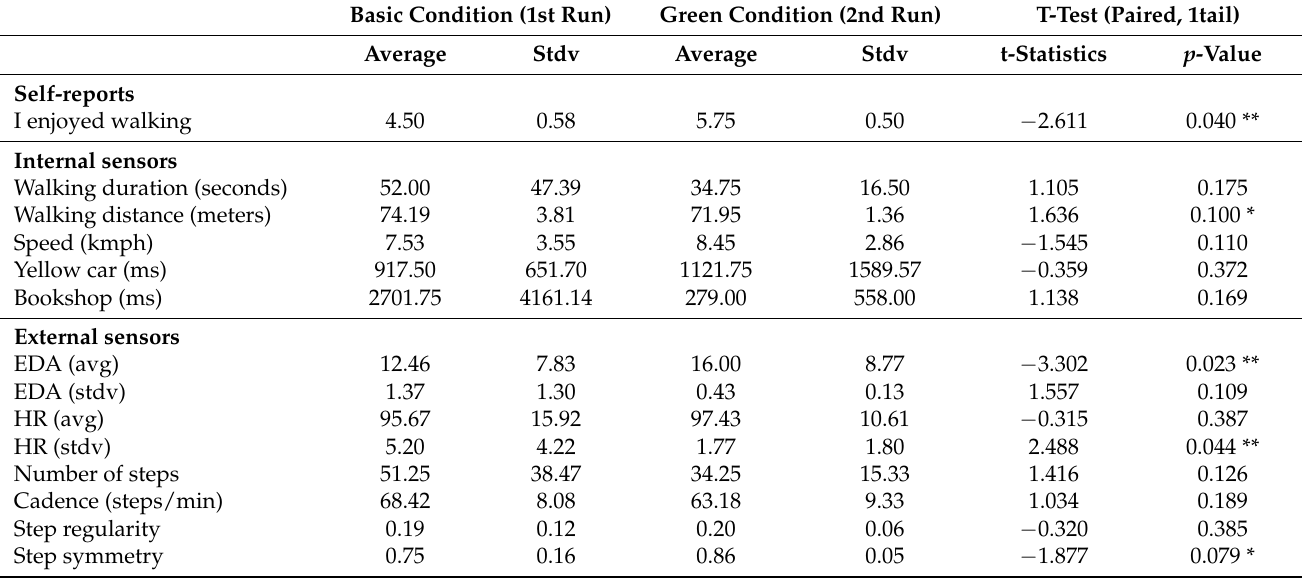
Table 2. Comparison of average values and t-tests between experiment conditions. Basic Condition (1st Run) Green Condition (2nd Run) T-Test (Paired, 1tail) Average